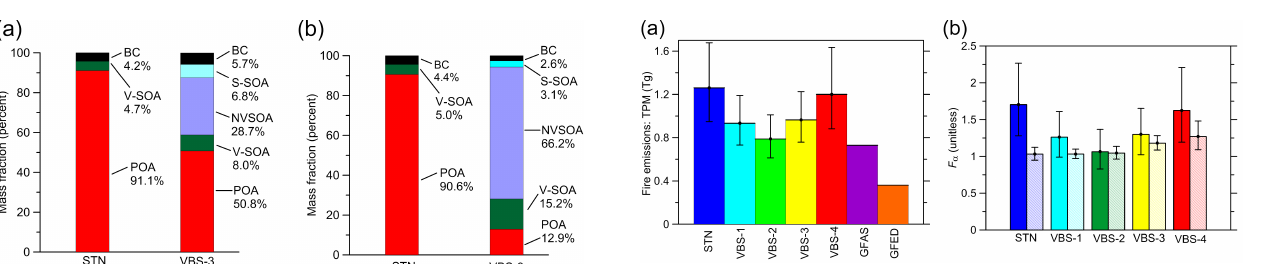
Figure 10. Composition of BB aerosol including primary organic aerosol (POA) species, secondary organic aerosol (SOA) species formed from oxidation of POA (S-SOA), secondary organic aerosol species formed from volatile organic compounds (V-SOA), non- volatile SOA species (NVSOA) assumed to be formed from the condensed-phase transformation of S-SOA species, and black car- bon (BC), according to simulation scenarios STN and VBS-3 (a) in Moscow (at 18:00UTC on 7 August 2010) and (b) in Kuopio (at 18:00UTC on 8 August 2010).